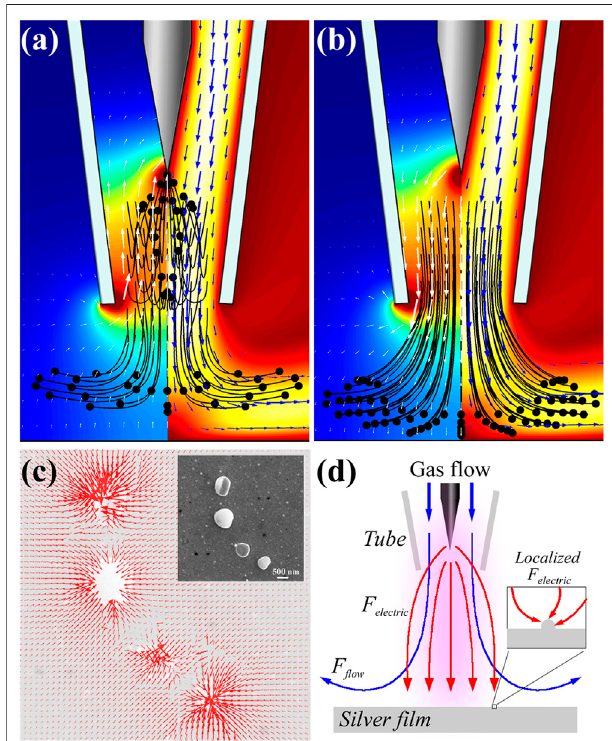
FIGURE 4 | The electrical fi eld directed diffusion of the plasma products between the needle-plate electrode and silver fi lm. (A,B) The electrical potential (left) and fl ow velocity (right) distribution above the silver fi lm. White and blue arrows denote the directions of the electrical fi eld and the gas fl ow,andtheblacklinesanddotsrepresentthetrajectoriesofpositiveions. (A) and (B) correspond to the negative/positive corona discharge, respectively; (C) Simulated two-dimensional pro fi le of the microscopic electrical fi led at the fi lm surface with the same nanoparticles distribution as shown in the inset; (D) The schematic of air fl ow (blue line) and electric force (red line) acting on positive ions in the plasma region (purple shadow), and the inset shows that the microscopic electric fi eld is directed to surface irregularity.